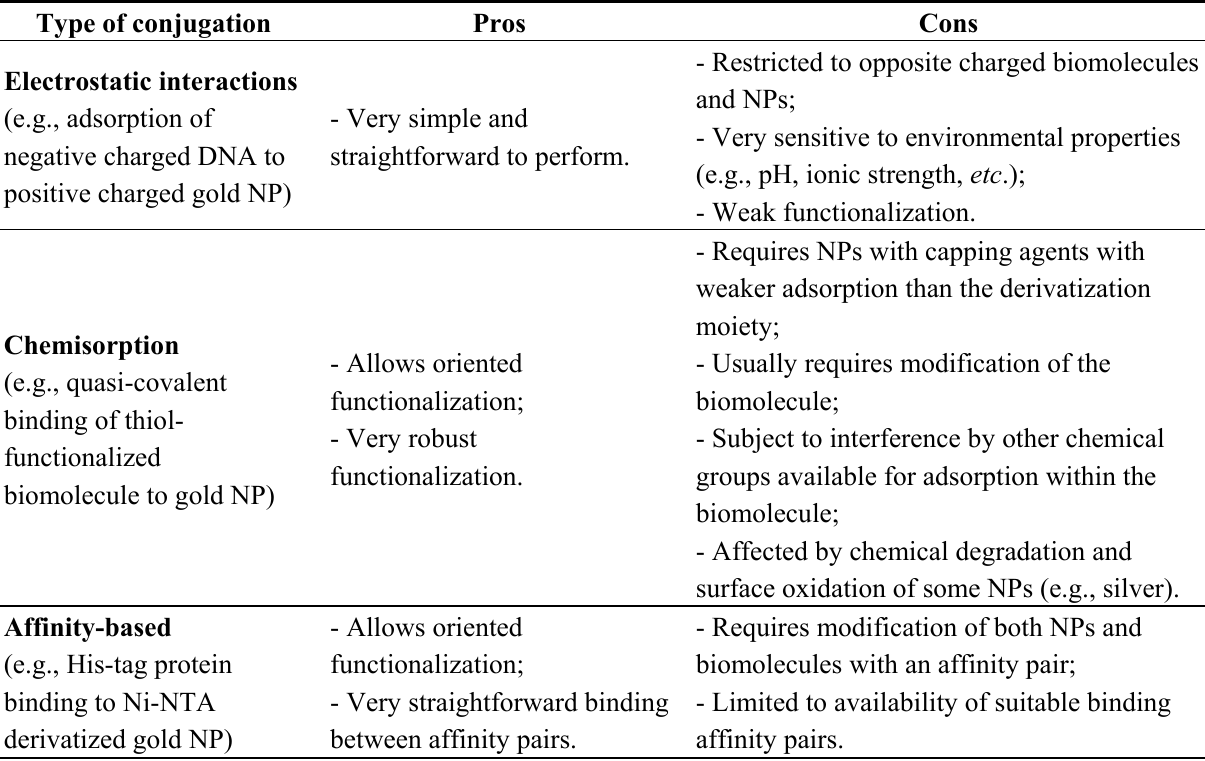
Table 1. Types of conjugations between biomolecules and noble metal